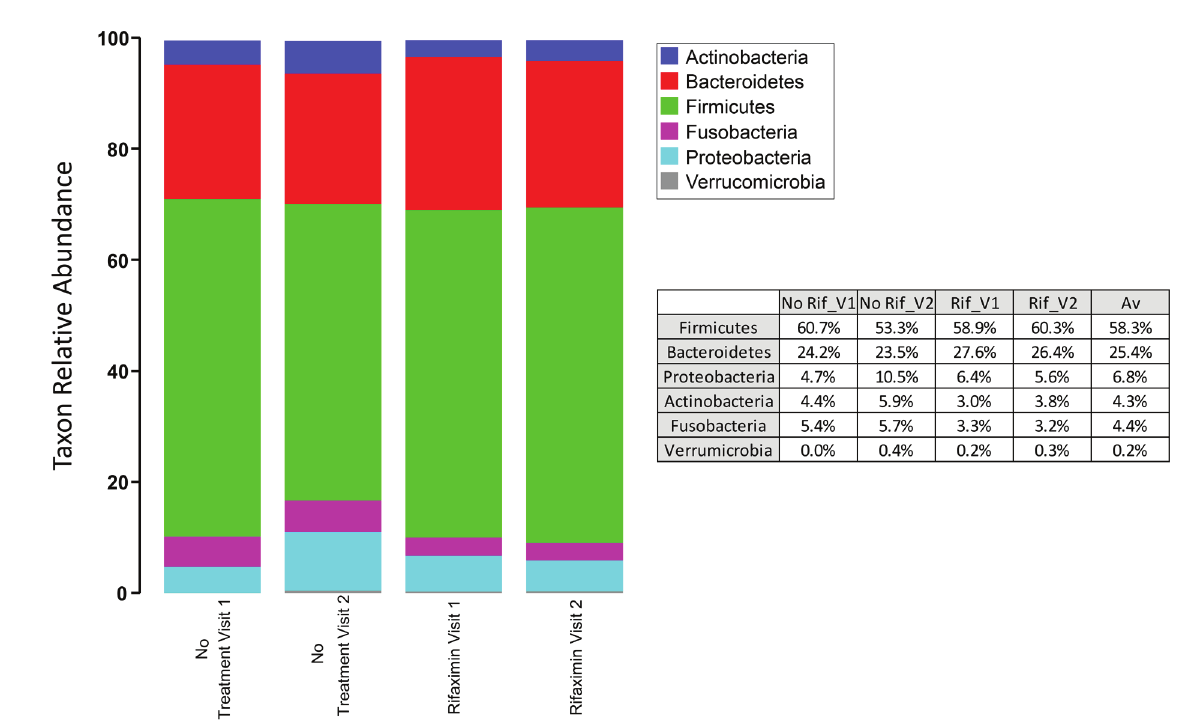
Figure 1C. Phylum-level microbial community composition of fecal microbiome samples from individ- uals in the rifaximin and placebo experimental arms. Average abundance of each taxon is shown among 31 individuals (rifaximin arm) and 17 individuals (no-treatment arm). Each sample was rarefied to 6500 sequences and average values for each taxon are shown. No taxa are significantly different between